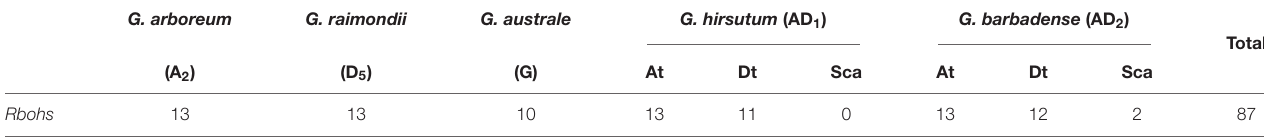
TABLE 1 | The number of Rboh genes in the five Gossypium species.